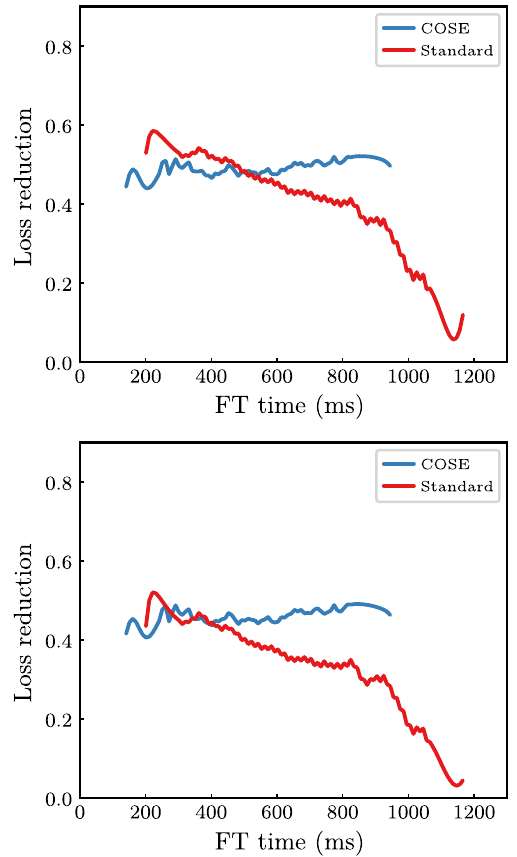
FIG. 11. Loss reduction with a bent crystal in LSS2 as function of time during slow extraction reconstructed from LHC type beam loss monitors at the peak loss location electrostatic septum ZS3 and crystal: The crystal was aligned to shadow the ES wires. As with tune sweep the separatix angle at the ES changes, the loss reduction is not constant over time and drops rapidly when reaching the edges of the crystal ’ s angular acceptance. With COSE on the other hand the loss reduction is constant within the noise level during slow extraction. (Unfortunately the spills for COSE and tune sweep had not been adjusted to the same length during the experiment. The discussed effects are however clearly demonstrated.)